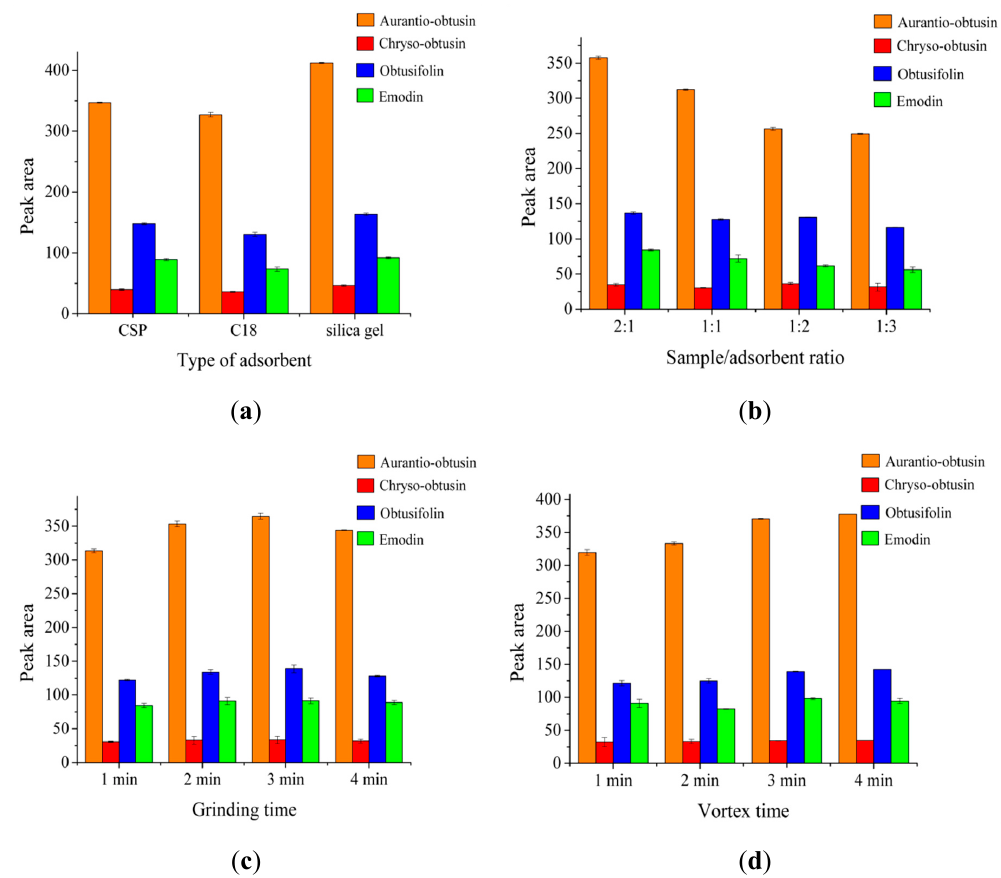
Figure 3. ( a )Effect of different adsorbents in VS-MSPD process; ( b ) effect of sample/adsorbent ratio in VS-MSPD process; ( c ) effect of grinding time in VS-MSPD process; ( d ) effect of vortex time in the VS-MSPD process.